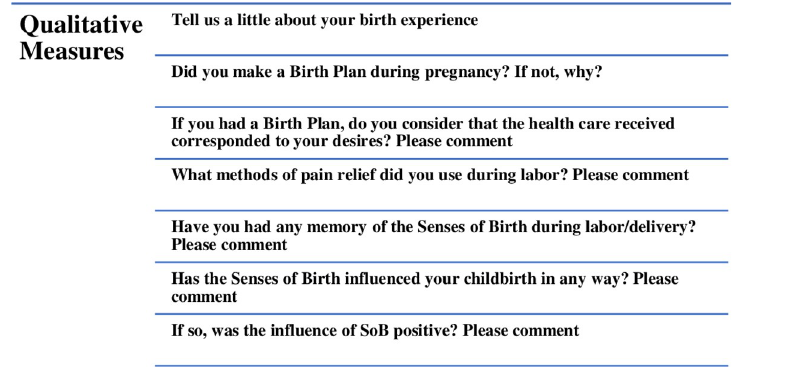
Fig 2. Open-ended questions answered by women on the follow-up SoB